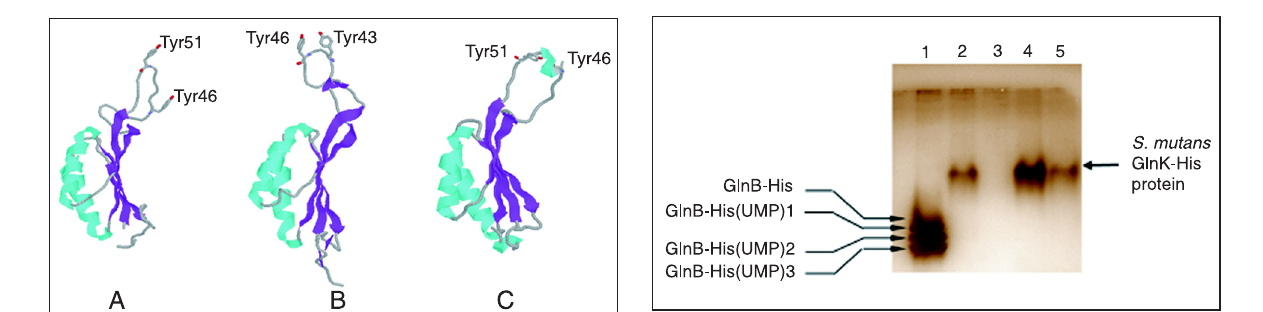
Figure 2. Uridylylation of Streptococcus mutans GlnK by Escheri- chia coli GlnD. Reactions were carried out as described in Mate- rial and Methods and loaded on non-denaturing polyacrylamide gel. The proteins were silver-stained. Lane 1 , Uridylylation reac- tion of Herbaspirillum seropedicae GlnB-His protein (2 μM); lane 2 , uridylylation reaction of GlnK-His-Sm (2 μM); lane 3 ,